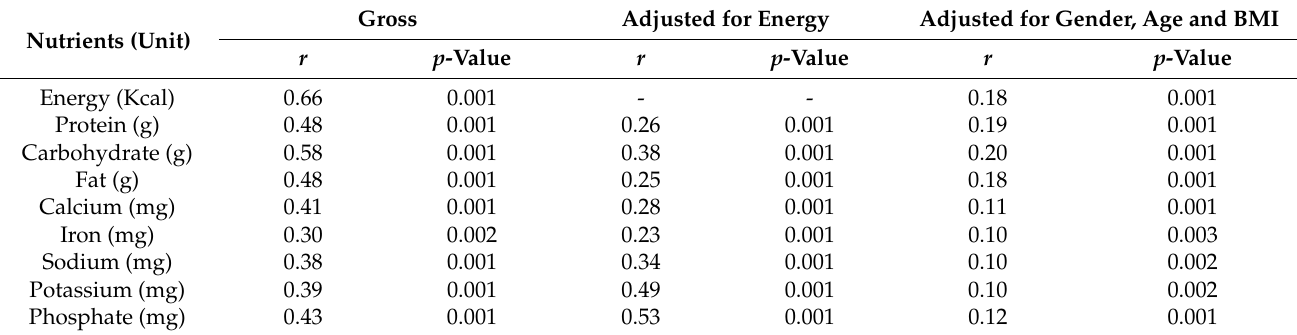
Table 3. Correlations of BDHD-FFQ with 3DDR methods according to